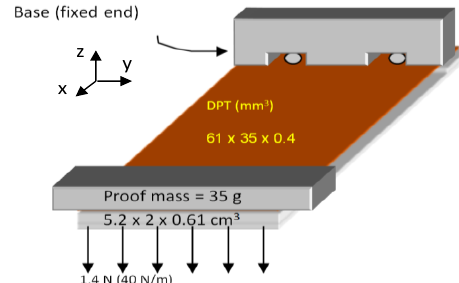
Figure 16. Schematics of the vibration energy harvester and FEA simulation boundary